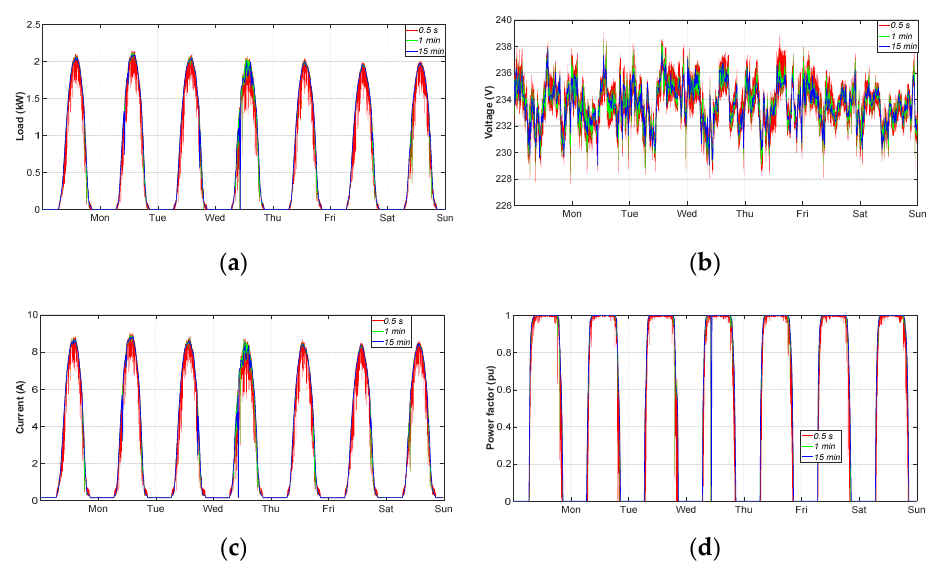
Figure 15. Weekly electrical data for PV: ( a ) power, ( b ) voltage, ( c ) current and ( d ) power factor.